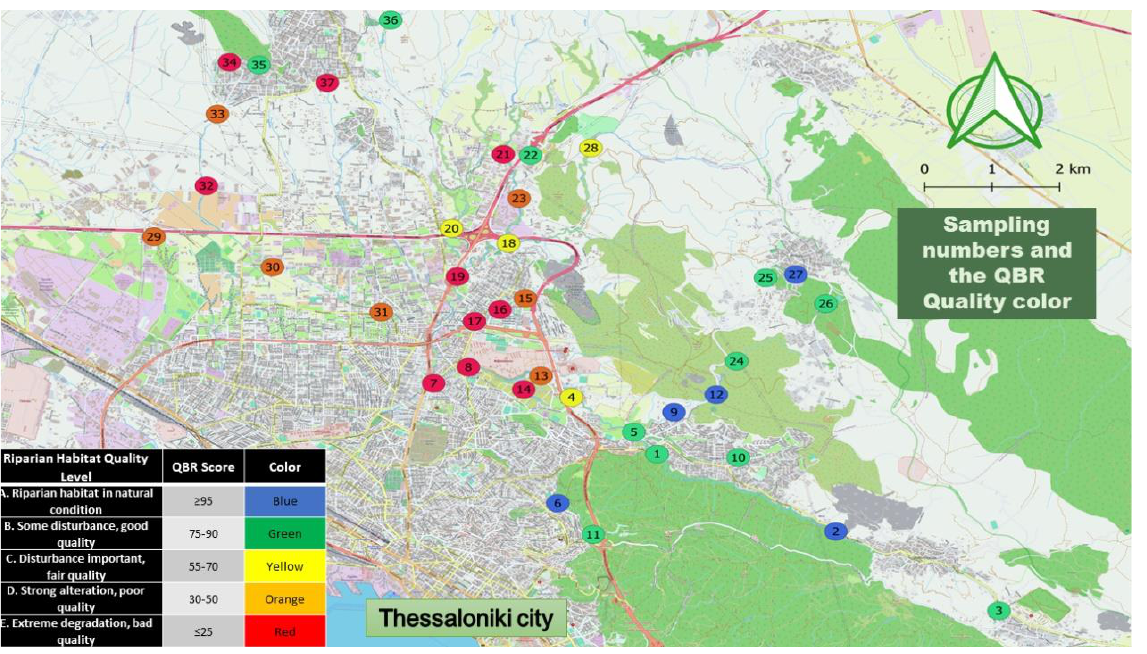
Figure 4. Position of the 37 sampling plots. Colored legend indicates the five main levels of riparian habitat quality (QBR) status, namely natural, good, fair, poor, and bad. habitat quality (QBR) status, namely natural, good, fair, poor, and